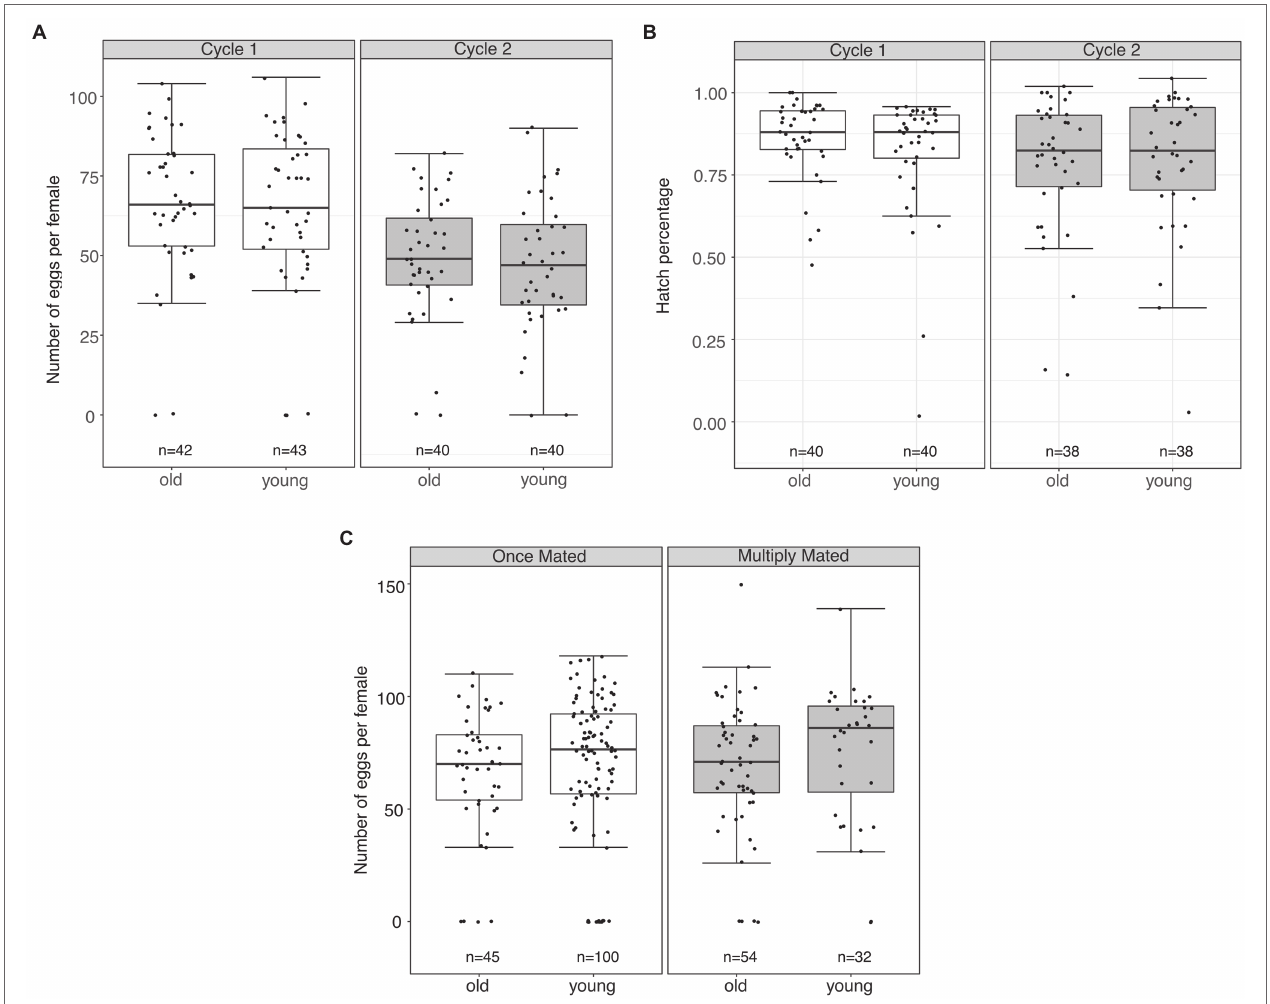
FIGURE 1 | Male age does not influence fecundity or fertility of Aedes aegypti females. (A) Total eggs laid for the first two oviposition cycles from females mated to old or young males. (B) Hatch percentage of eggs from the first two oviposition cycles from females mated to old or young males. (C) Total eggs laid by singly mated females to old or young males (left panel), and multiply mated females initially mated to old or young males (right panel). The middle horizontal line in the box plots represents the median, the lower and upper margins of the box represent the 25th and 75th quartile, and the whiskers extend to the minimum and maximum of the data (excluding outliers, shown as points outside the whiskers).